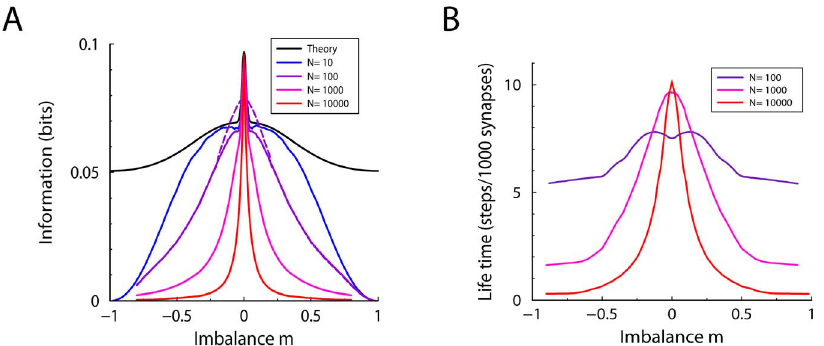
Figure 5. The effect of imbalance between potentiation and depression on the capacity measures for hard-bound plasticity. A. The Information capacity showing the theory (black) as well as simulations for 10, 100, 1000, and 10000 synapses for a 0 ~ 0 : 01 (blue, violet and magenta). In contrast to the balanced case ( m ~ 0 ) the capacity depends on the number of synapses. A larger synaptic update always decreases capacity in the balanced case, but can improve capacity in the imbalanced case (dashed curve, N ~ 100 , a 0 ~ 0 : 1 ). B. Memory lifetime decreases when potentiation and depression are imbalanced. The memory lifetime was optimized w.r.t a 0 for every setting of m and N .